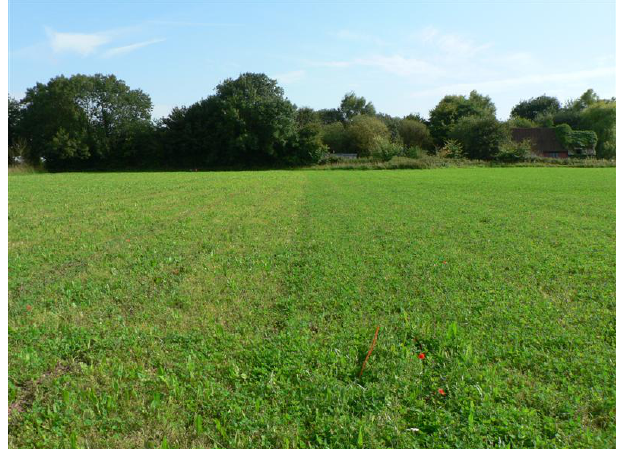
Figure 1. Photograph of an on-farm trial at Wakelyns Agro- forestry, Suffolk, taken in the summer of 2010. On the left, slightly paler, the control ley (white clover-chicory-black medic mix), on the right the All Species Mix (ASM). A different site on the same farm was also used for replicated